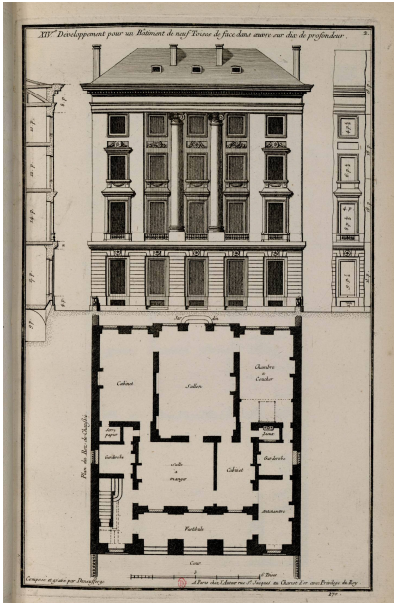
Figure 4. Building 9 × 10 toise/17.541 × 19.49 m. Vol. III, cap. 29, tav. 2, p.